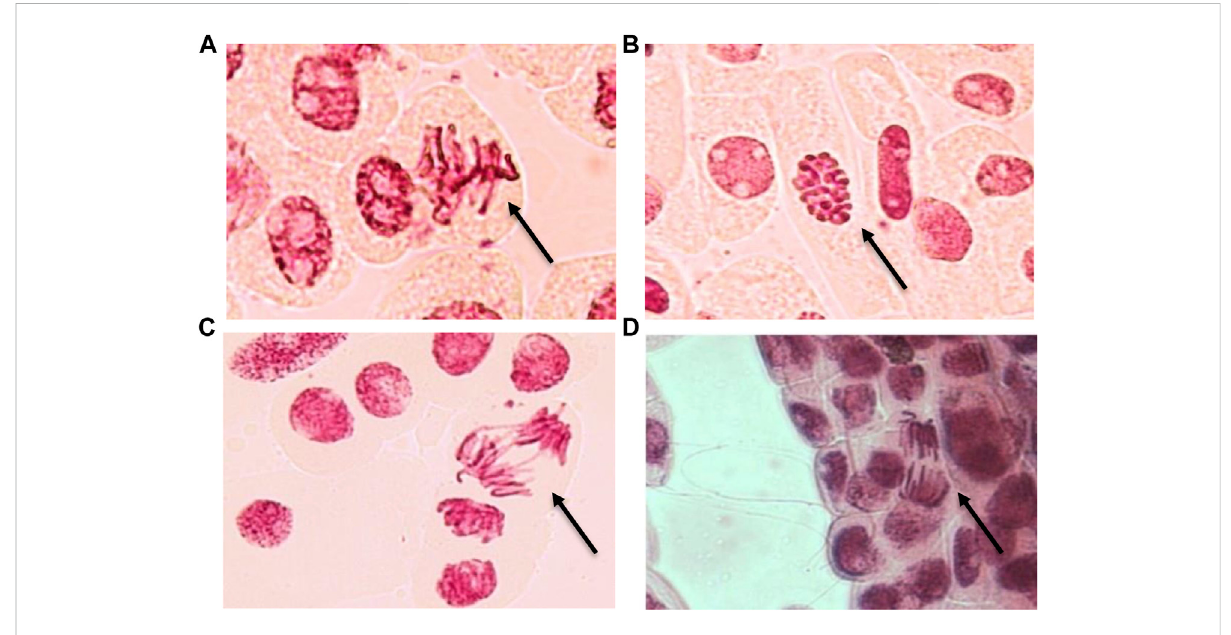
FIGURE 2 Mitotic aberrations observed in onion meristematic cells exposed to Ce (A – C) and Nd (D) at 100 µM. (A) sticky chromosome, (B) C-mitosis, (C) bridge and (D) vagrant chromosome. Magni fi cation ×400.